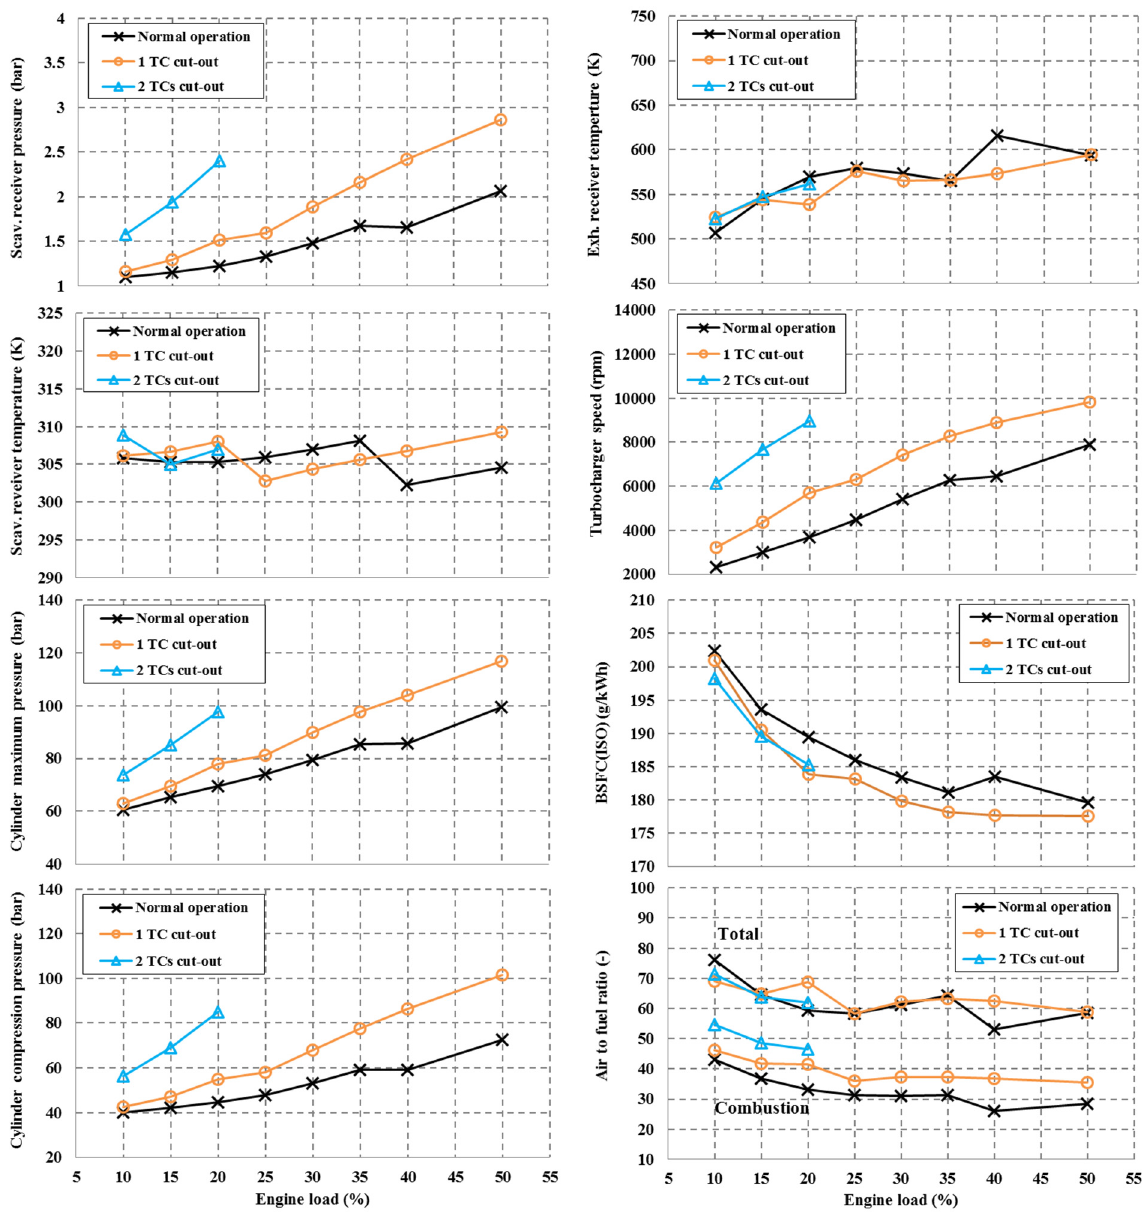
Figure 6. Steady state simulation results for normal operation and turbocharger cut-out. (Blowers are activated as follows: below 40% load for normal operation; below 25% load for operation with 1 TC cut-out; at 10% load for operation with 2 TCs cut-out). The adoption of one turbocharger unit cut-out (out of three) caused a substantial rise of the turbocharger speed and as a result, the increase of the scavenging receiver pressure. In this respect, greater total engine air flow is obtained as it is deduced by the engine total air to fuel ratio values, which are greater than the ones of normal engine operation in the region from 40% to 50% (where the blowers are switched off) and almost the same with the ones of the normal engine operation for the region within 25% to 35% load (where the blowers are switched on). In addition, more air amount remains into the engine cylinders as it is observed by considering the combustion air to fuel ratio values, which increase in the load region from 25% to 50% of MCR. The increased scavenging receiver pressure results in the rise of the cylinder compression and maximum pressures and the consequential reduction of